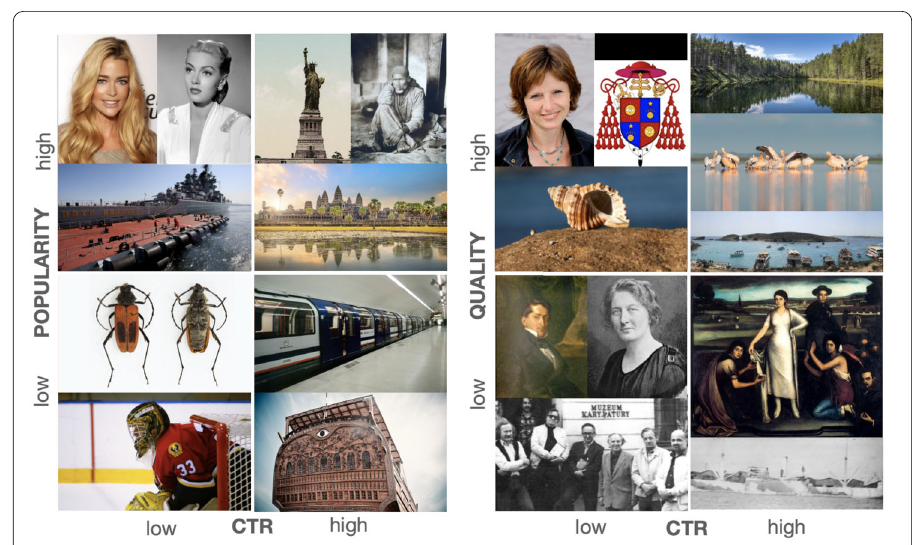
Figure 8 Examples of high and low image-specific CTR images by page popularity (left) and image quality (right). We ranked images by iCTR, popularity and quality, and picked examples from the top-100 (“high”) and bottom-100 (“low”) for each